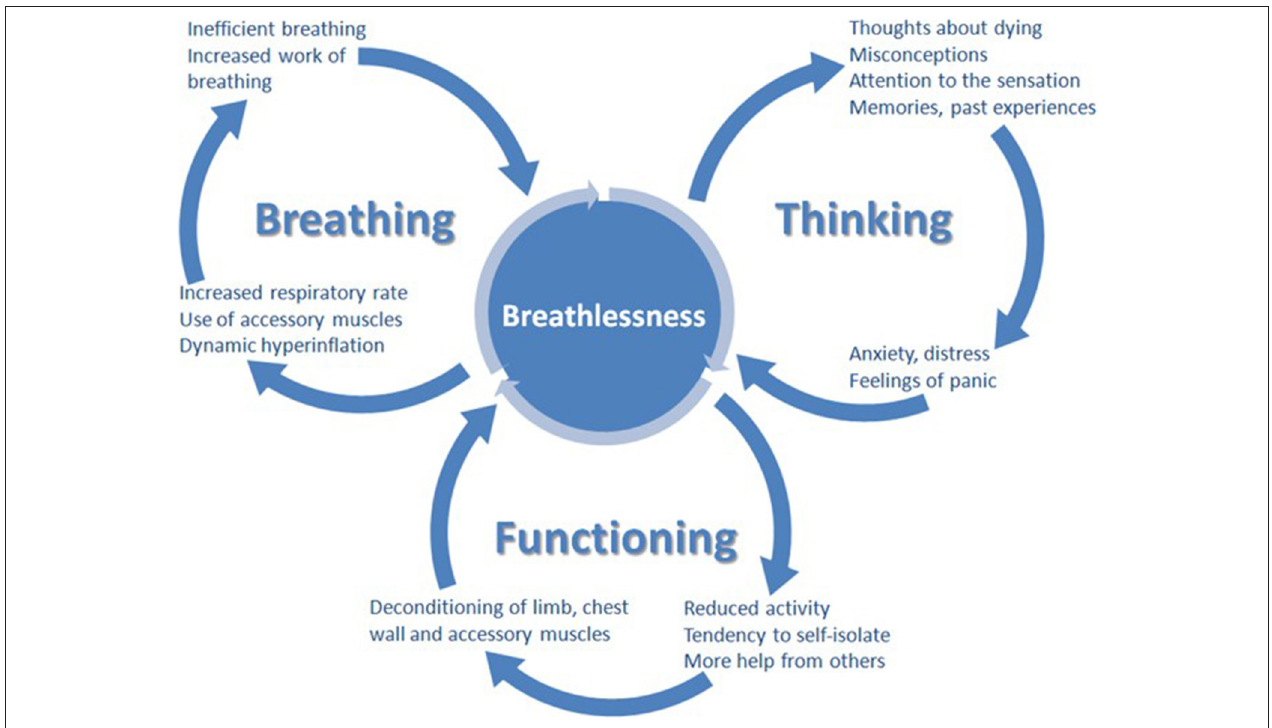
FIGURE 1 | The breathing, thinking, functioning clinical model (98).